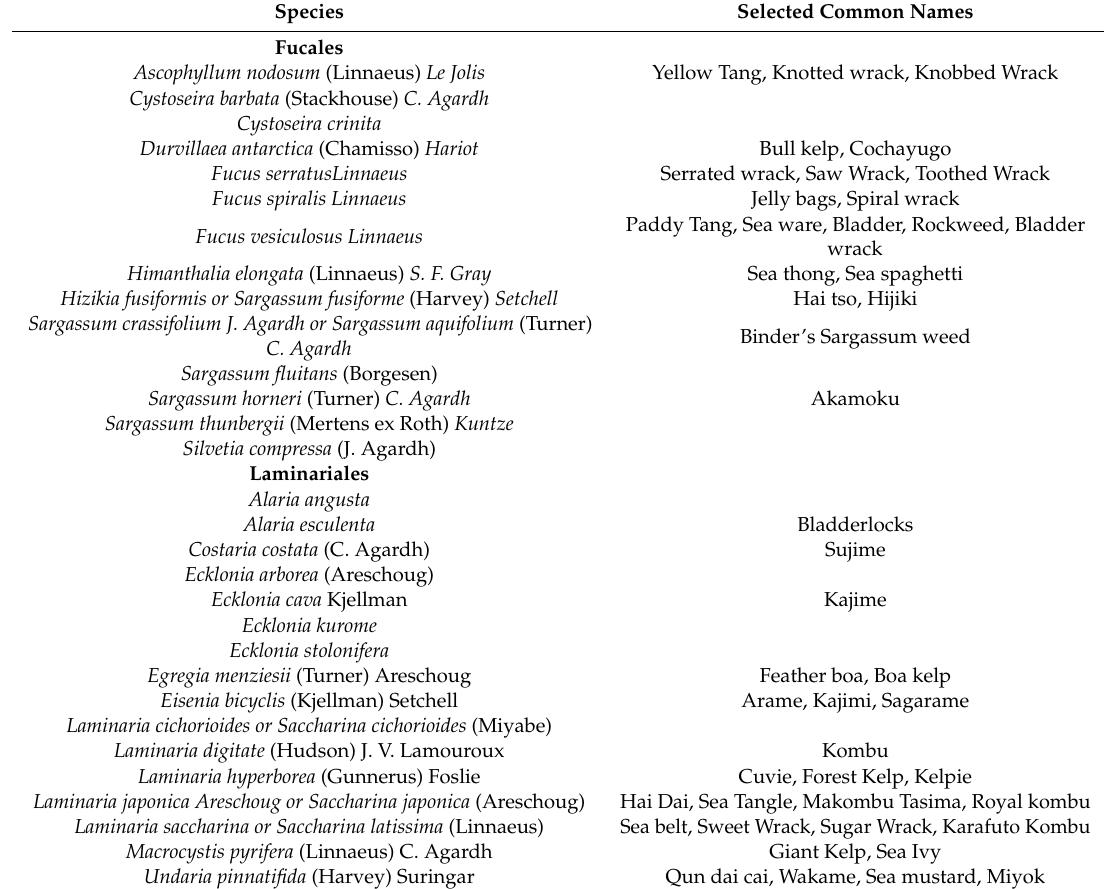
Table 1. List of some brown algal species belonging to Fucales and Laminariales (Algabase database) with the common names used in the literature, when